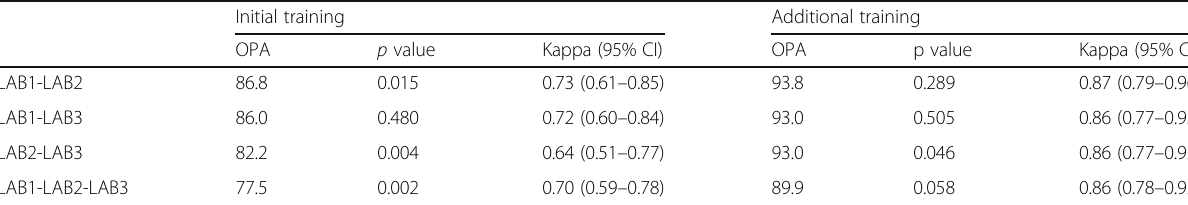
Table 2 Agreement of p16/Ki-67